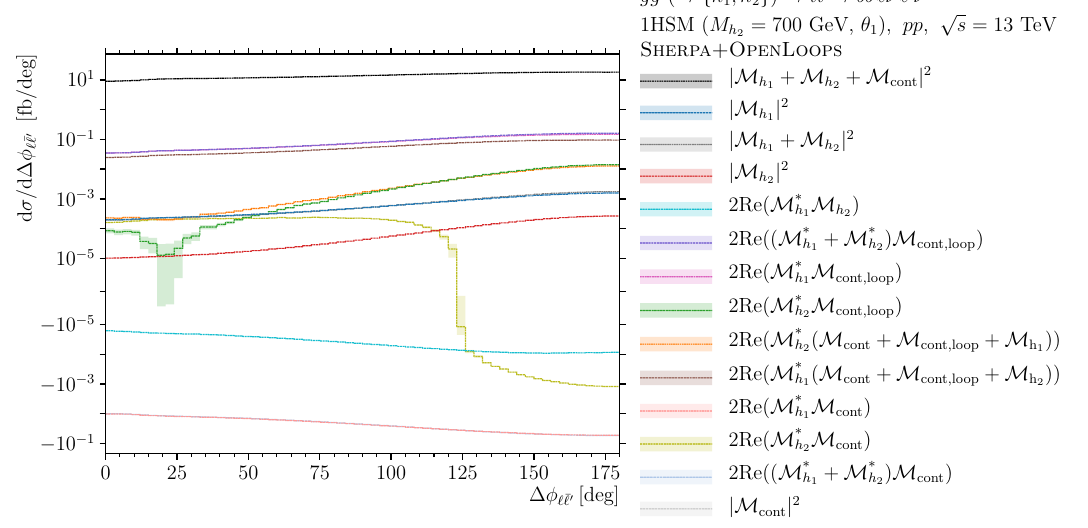
Figure 14 . ∆ φ distributions for the signal process gg ( (cid:31) ¯ (cid:31) (cid:31) = 700 GeV, θ 1 ) including its interference with the background in pp collisions at the 1HSM ( M h 2 √ s = 13 TeV. Other details as in figure 10.